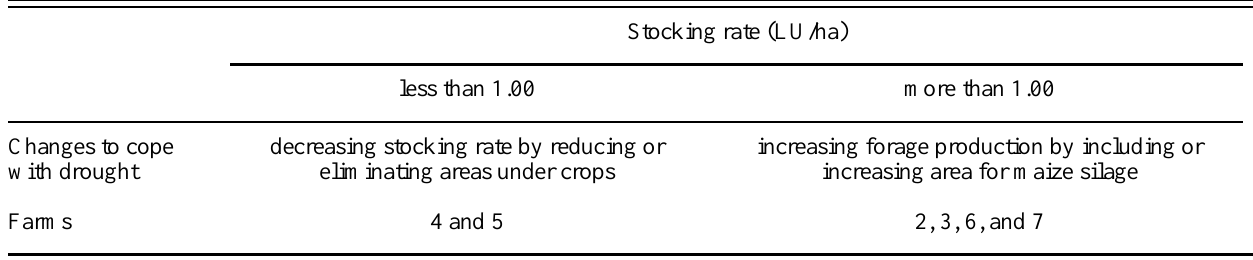
Table 3. Main changes in the extensive beef cattle farming systems studied to cope with